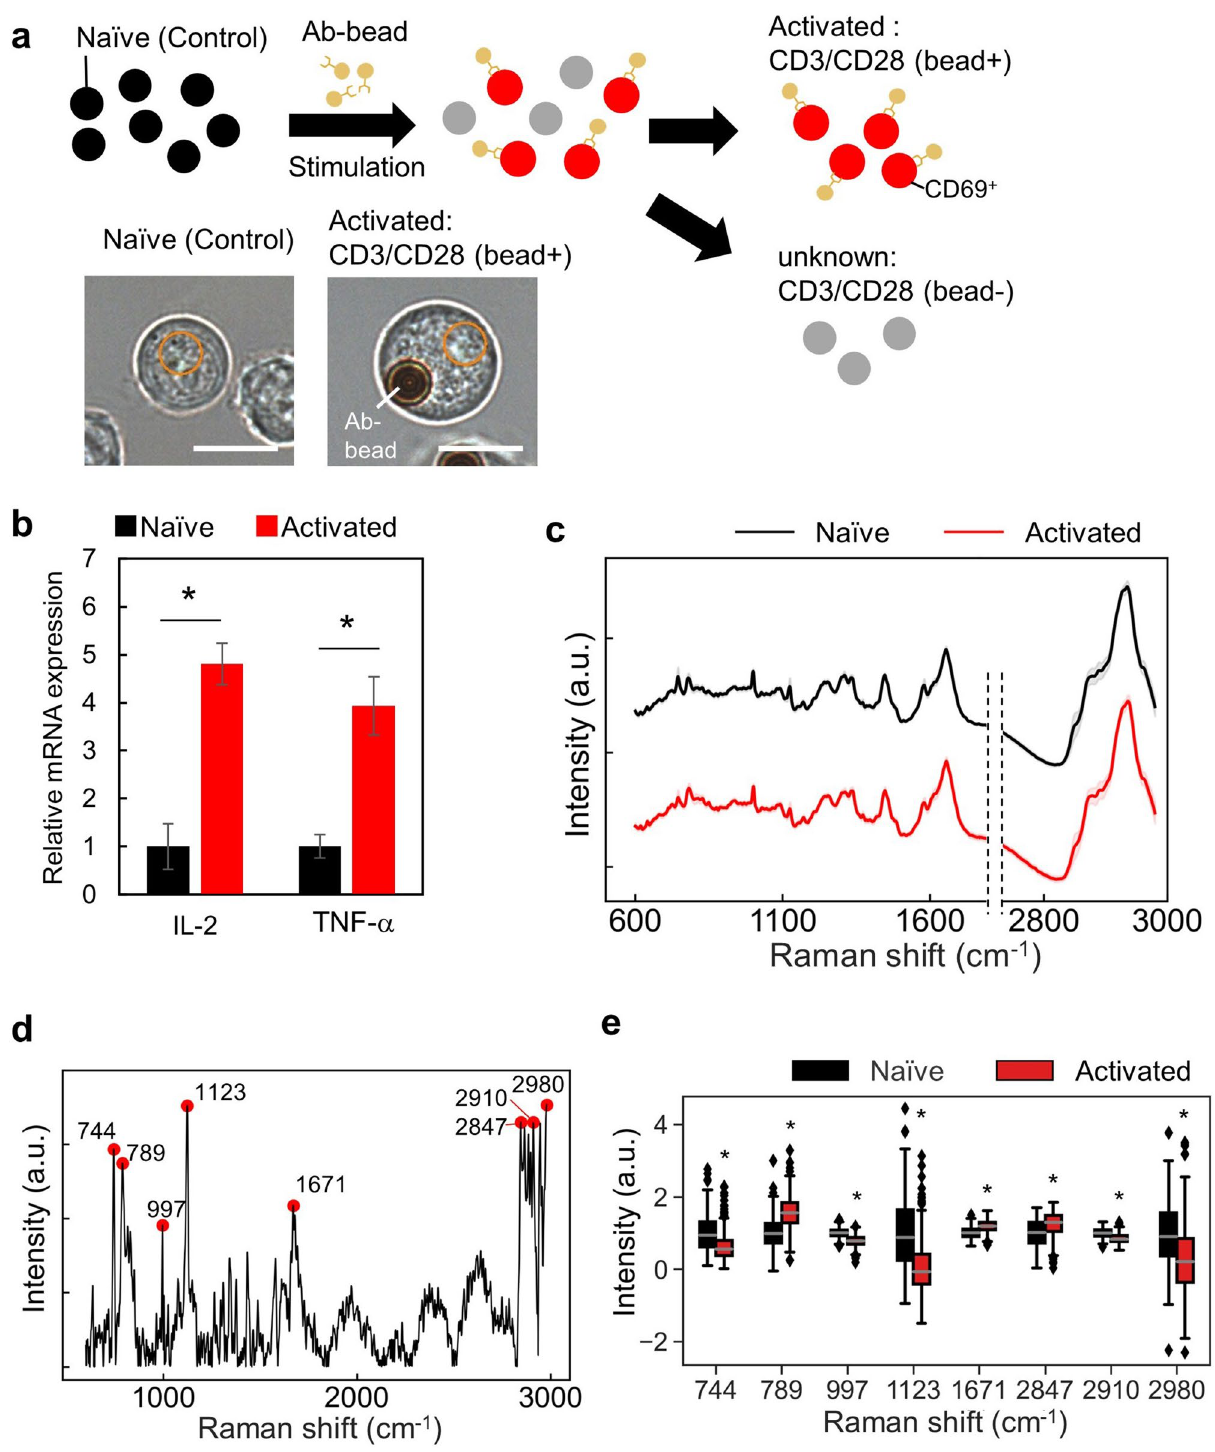
Figure 4. Comparison of Raman spectra of activated or naïve cells. ( a ) Schematic of cell stimulation of Jurkat cells using anti-CD3/CD28 conjugated beads. In the lower left, bright field image of activated or naïve cells is shown. The diameter of the circular area is 5 μm. Scale bar: 10 μm. ( b ) qRT-PCR of IL-2 and TNF-α mRNA from naïve or CD3/CD28-activated Jurkat cells ( n = 3, error bar shows SDs; Student’s t test. * P < 0.05). ( c ) Averaged spectra of the analyzed region (600–3000 cm −1 ) for each cell type. SDs are shown by the shaded deviation. (black: naïve cells, red: activated cells). ( d ) Absolute value of spectrum intensity difference between control and stimulated cells. Detected peaks are shown as red plots (peak wave number: 744, 789, 1123, 1671, 2847, 2910, 2980 cm −1 ). ( e ) Comparisons of the spectrum intensity between naïve and activated cells for detected peak region. (n = 300; Error bars indicate the SD; median is shown as a grey line; Student’s t test or Welch’s t test, * P <